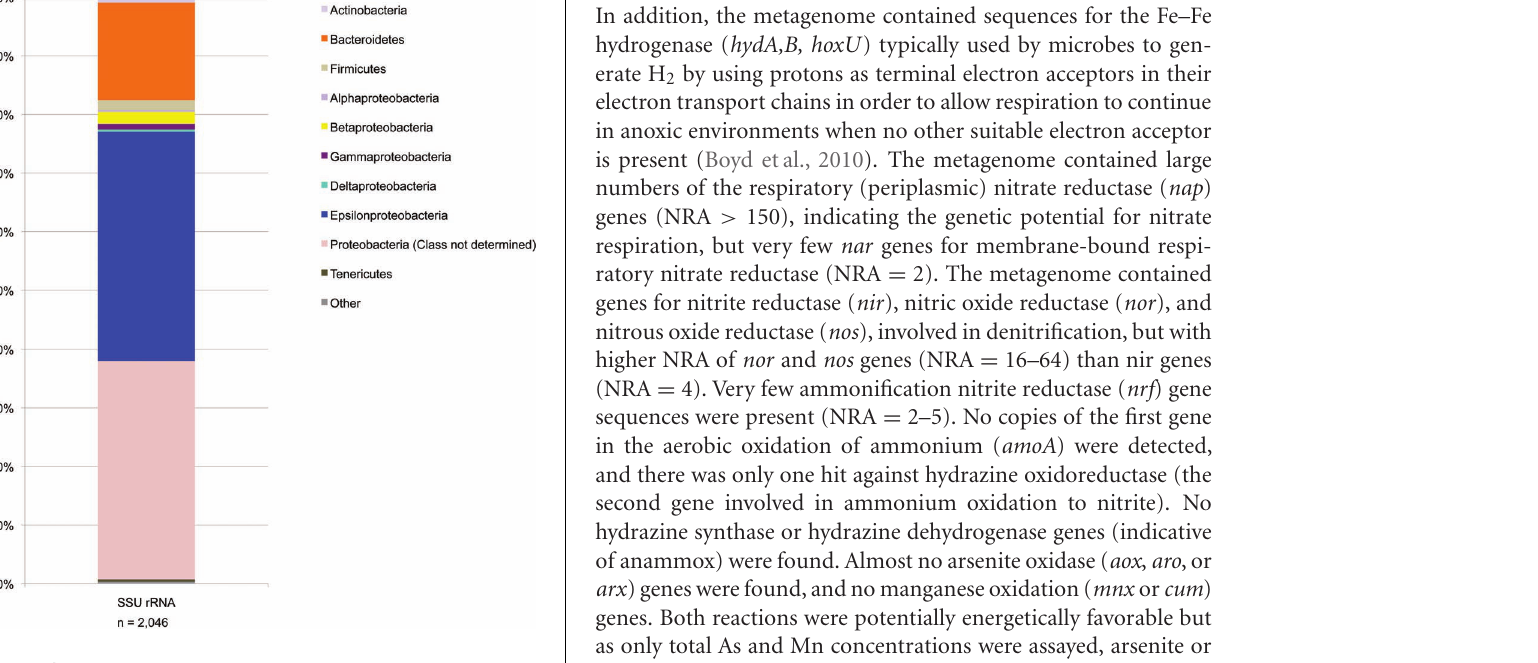
FIGURE 4 | SSU rRNA gene sequence data from the metagenome shotgun library. Data are shown at the phylum level except that the proteobacteria have been split into classes. For some metagenome sequences the most closely related sequences in the Greengenes database were identified as proteobacteria but without specifying which Class.These are the sequences included in the “Proteobacteria (class not determined)” group. Phyla which represent less than 0.1% of sequences are included in